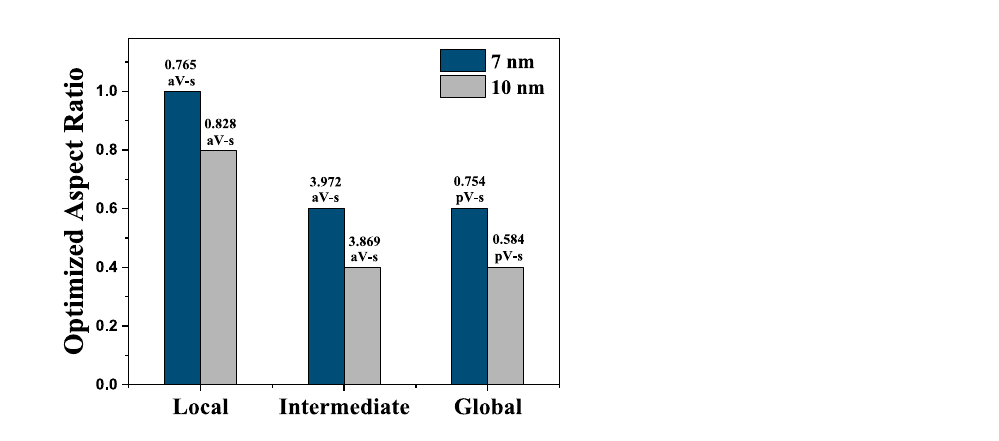
Figure 13. Impact of scaling on Fecl 3 doped MLGNR interconnect considering FOM at local, intermediate and global